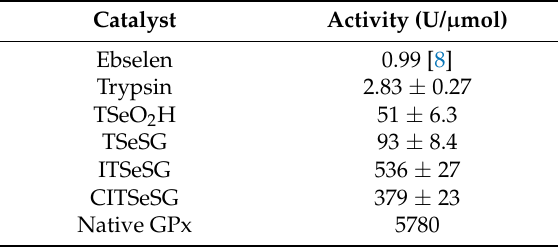
Table 2. Comparison of GPx activities of the GPx mimic-catalysed reduction of H 2 O 2 by GSH and native GPx.